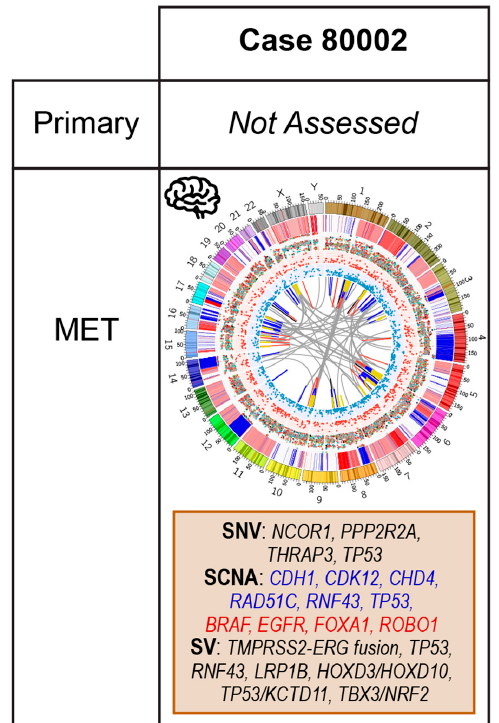
Figure 7. Summary of relevant genomic alterations for case 80002 with a brain metastasis at the time of sampling (80002) and Circos plots as per Figure 3.